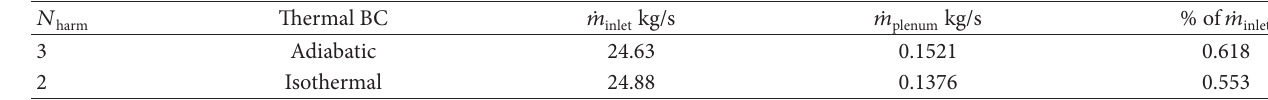
T 5: Plenum exit mass �ow and aspiration percentage of inlet mass �ow.